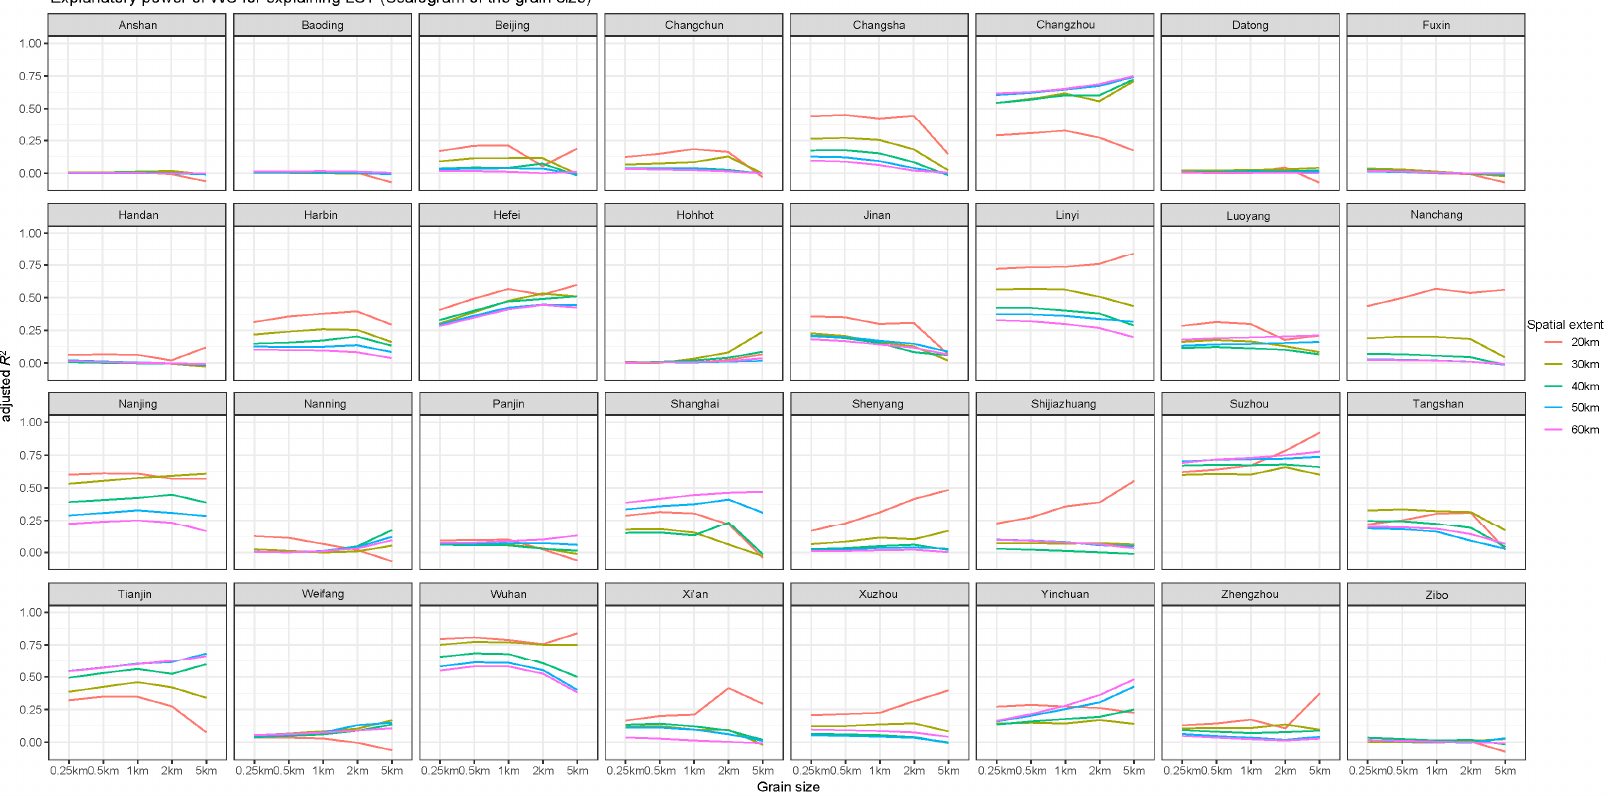
Figure A6. Explanatory power of WC for explaning LST(Scalogram of the grain size).